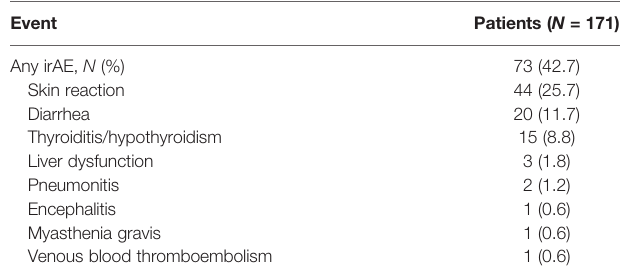
TABLE 1 | Baseline clinicodemographic characteristics. Characteristic Patients ( N =